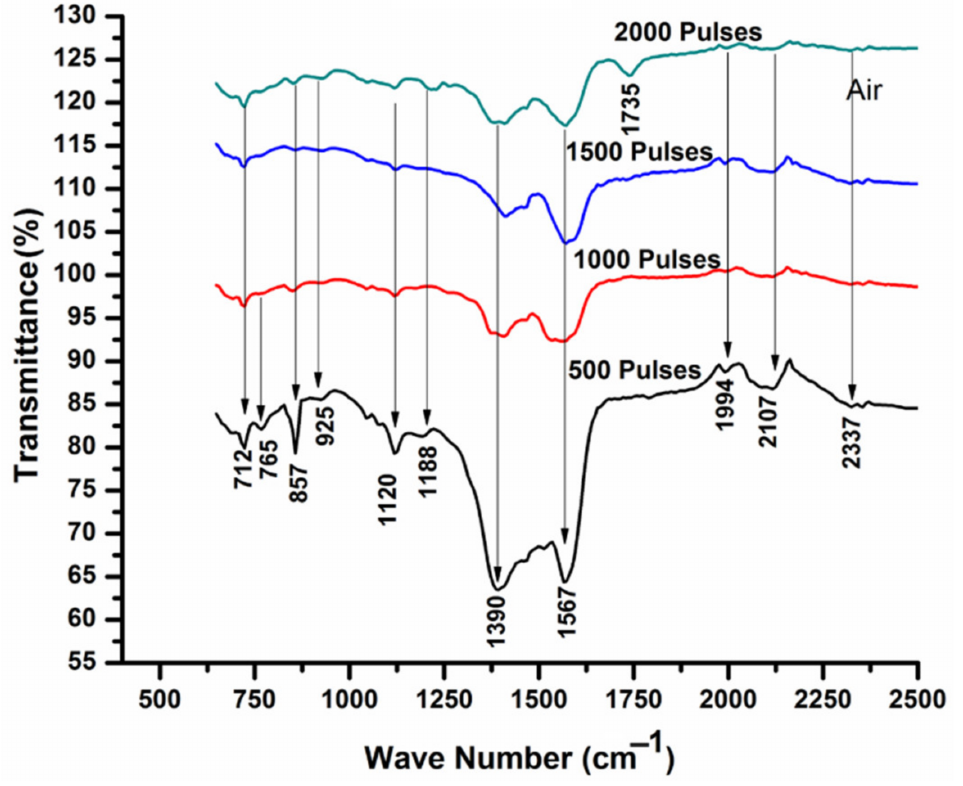
Figure 8. FTIR analysis of laser-ablated Cd exposed for 500, 1000, 1500 and 2000 laser pulses, at constant fluence value of 3.6 J cm − 2 in air.